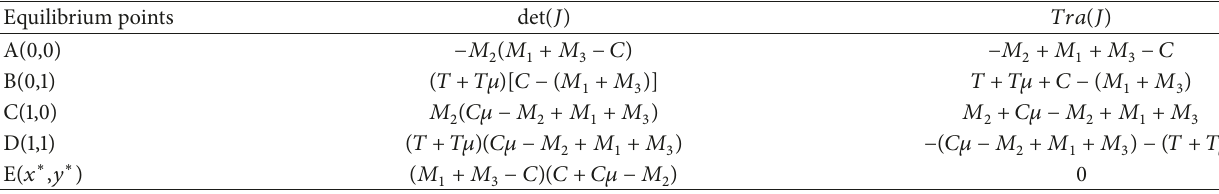
Table 3: The determinant and trace results of equilibrium points.